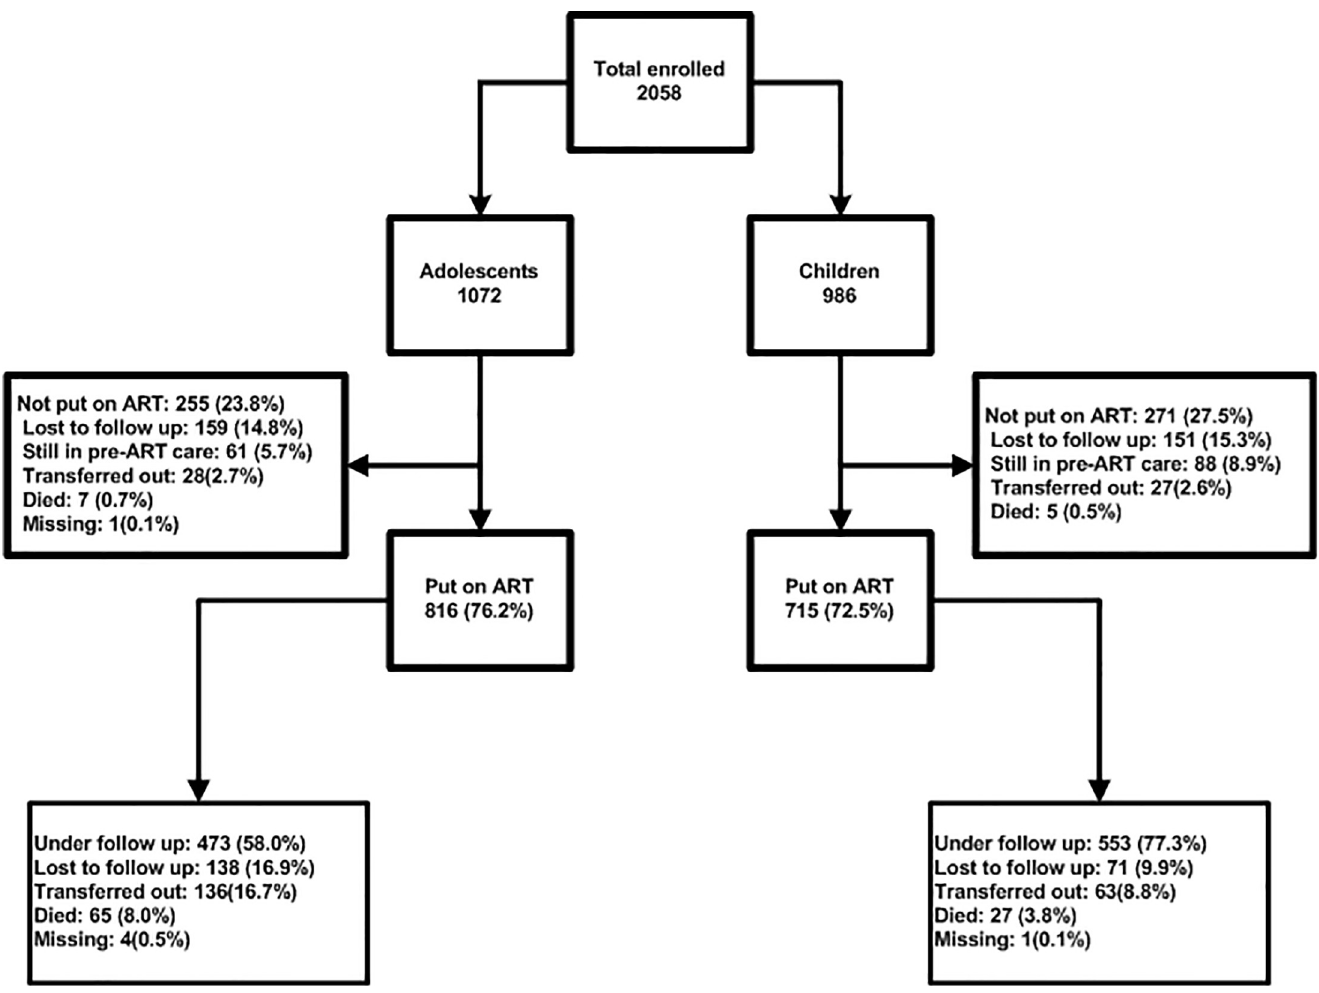
Fig 1. Cohort profile and follow-up status of